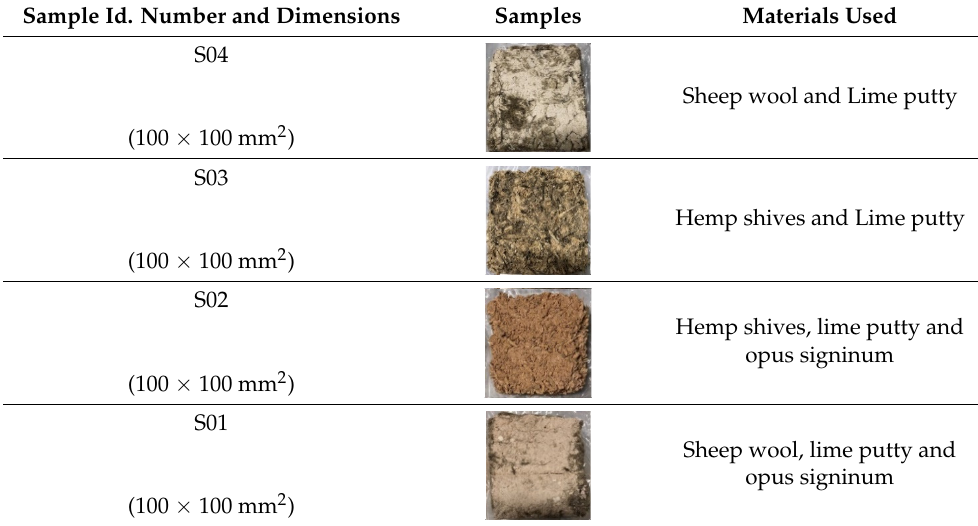
Table 3. Discarded samples, prepared at the first attempt.